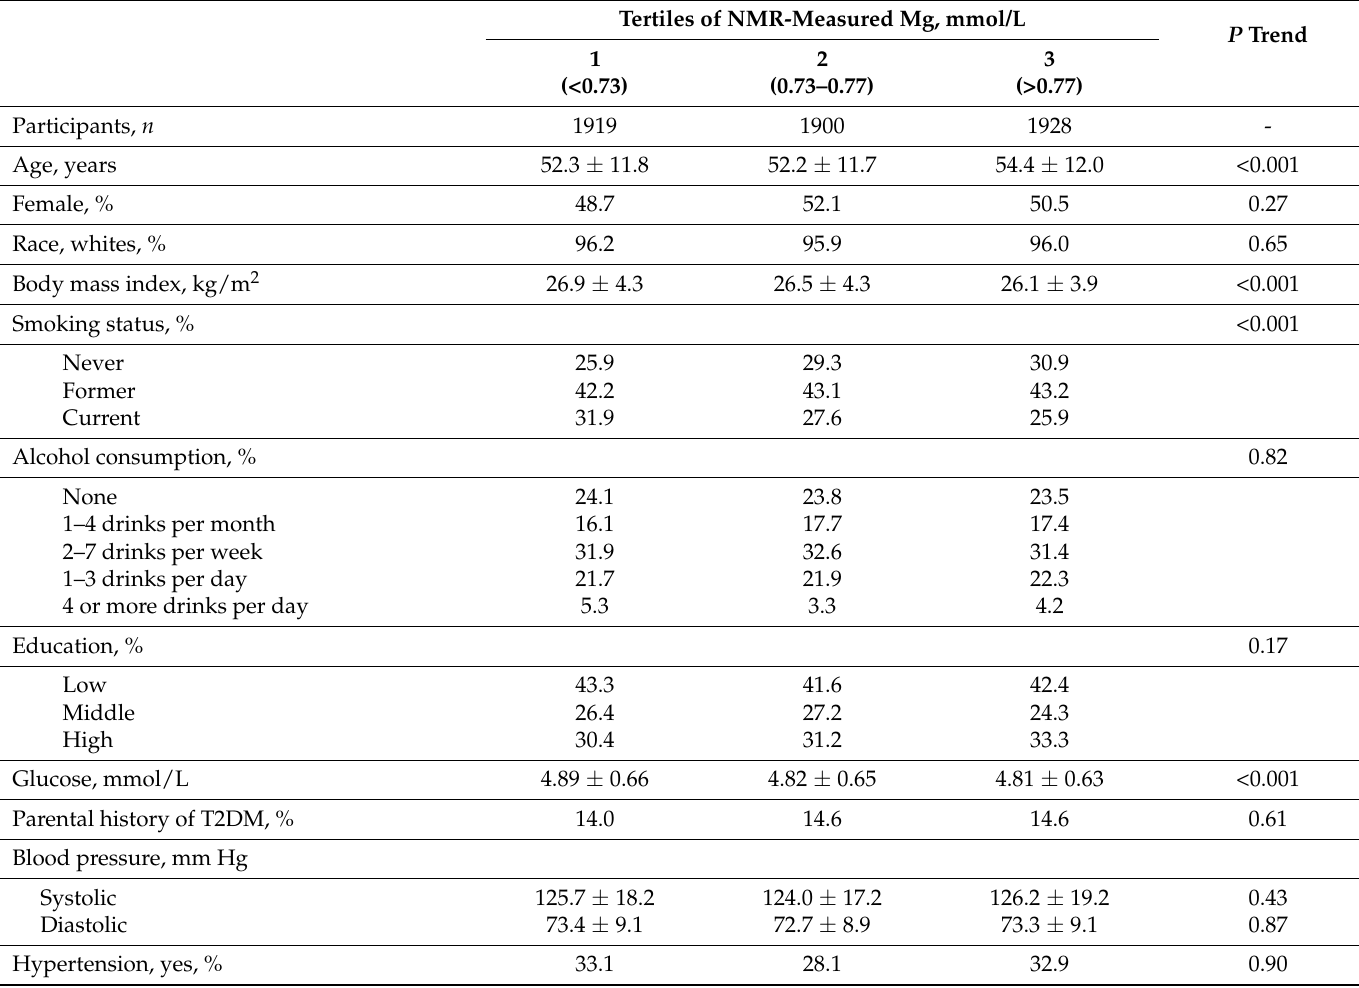
Table 2. Baseline characteristics of the PREVEND study